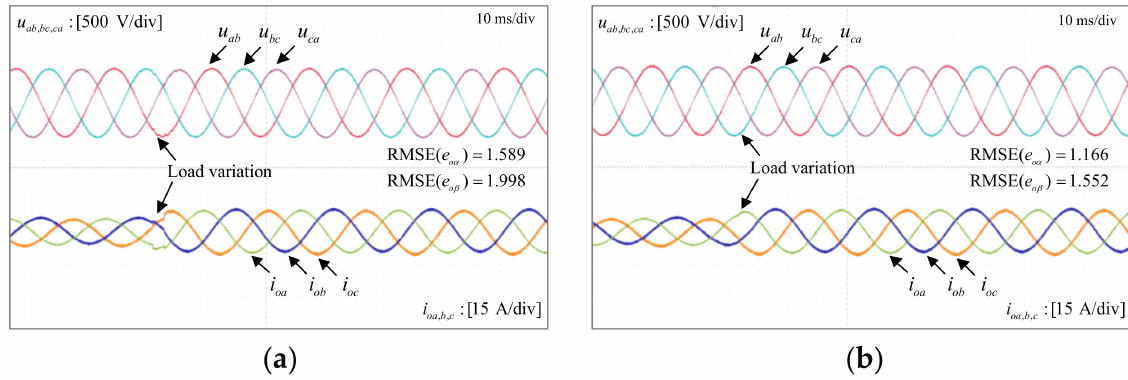
Figure 14. Experimental waveforms of inverter output voltages ( u ab , u bc , u ca ) and currents ( i oa , i ob , i oc ) under load variations: ( a ) quasi-PRC; ( b ) proposed